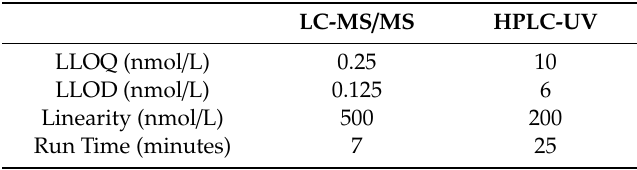
Table 1. Comparison of performance parameters for the liquid chromatography-tandem mass